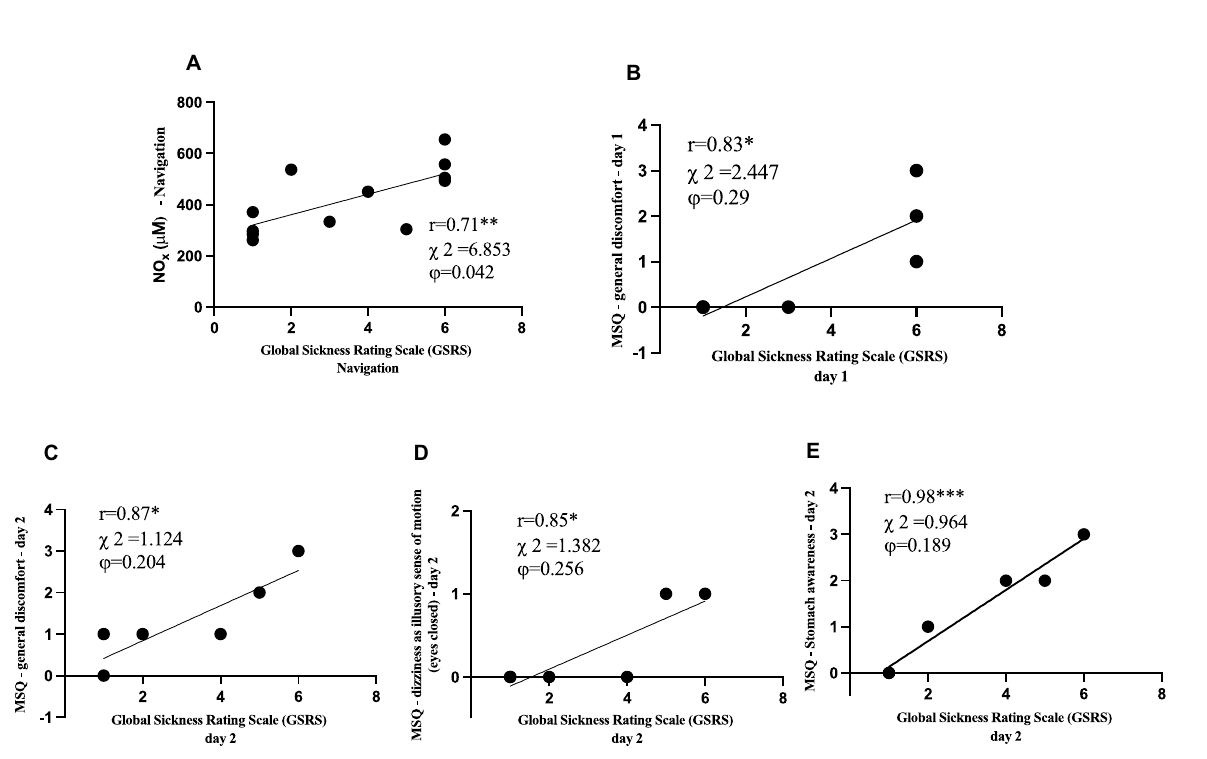
Figure 3. Relationship panel plot of: ( A ) NOx and GSRS during navigation; ( B ) GSRS and general discomfort of MSQ at 1st day; at the 2nd day, the panels show the correlation between GSRS and specific items of MSQ. ( C ) General discomfort and GSRS. ( D ) Dizziness as illusory sense of motion (eyes open) and GSRS. ( E ) Stomach awareness and GSRS. A significant linear relationship (p < 0.05–0.001) between parameters was estimated. The correlation coefficient (r), Chi-Square ( χ 2 ) and Phi coefficient (ϕ) are reported. Figure created with: GraphPad Prism, GraphPad Software inc. California, USA, version 9.0.1, https:// www. graph pad.